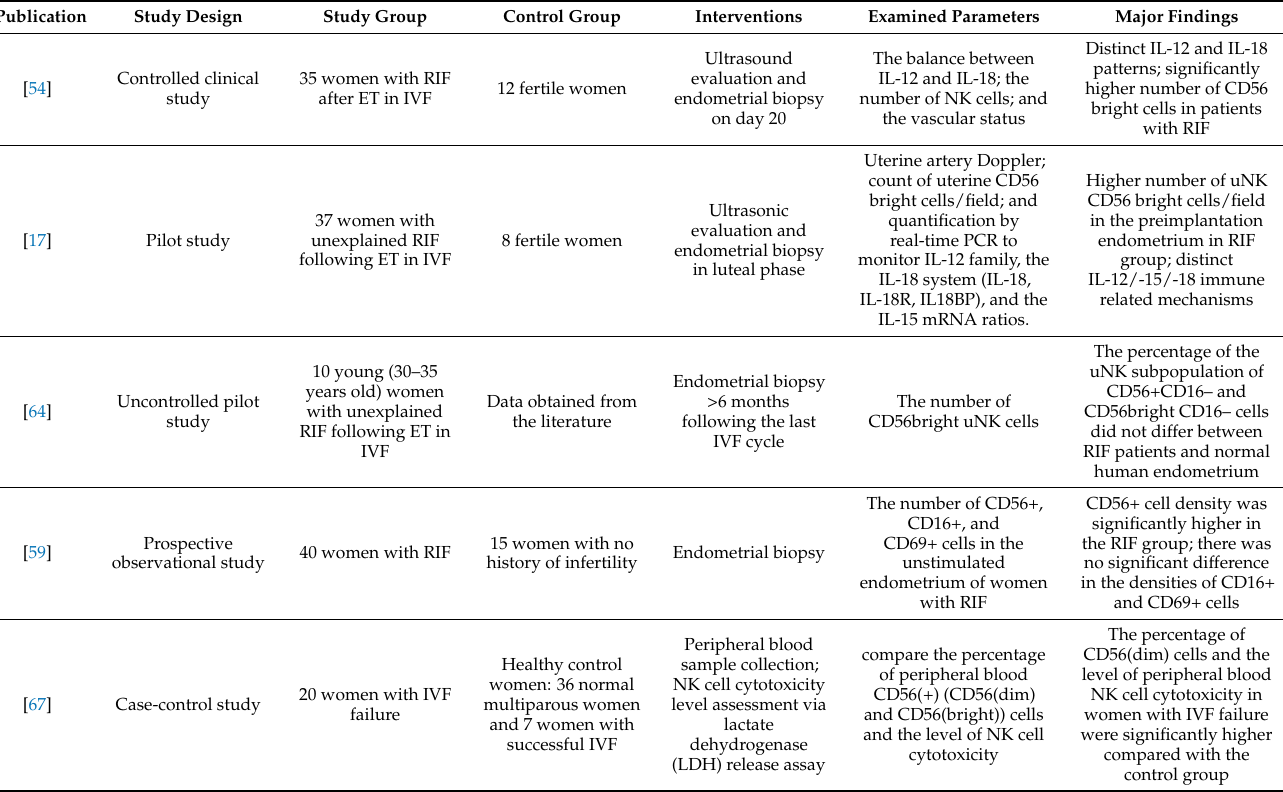
Table 1. Summary of the current evidence with regard to the role of uterine natural killer cells in recurrent implantation failure, highlighting the examined parameters as well as the major findings of the analyzed